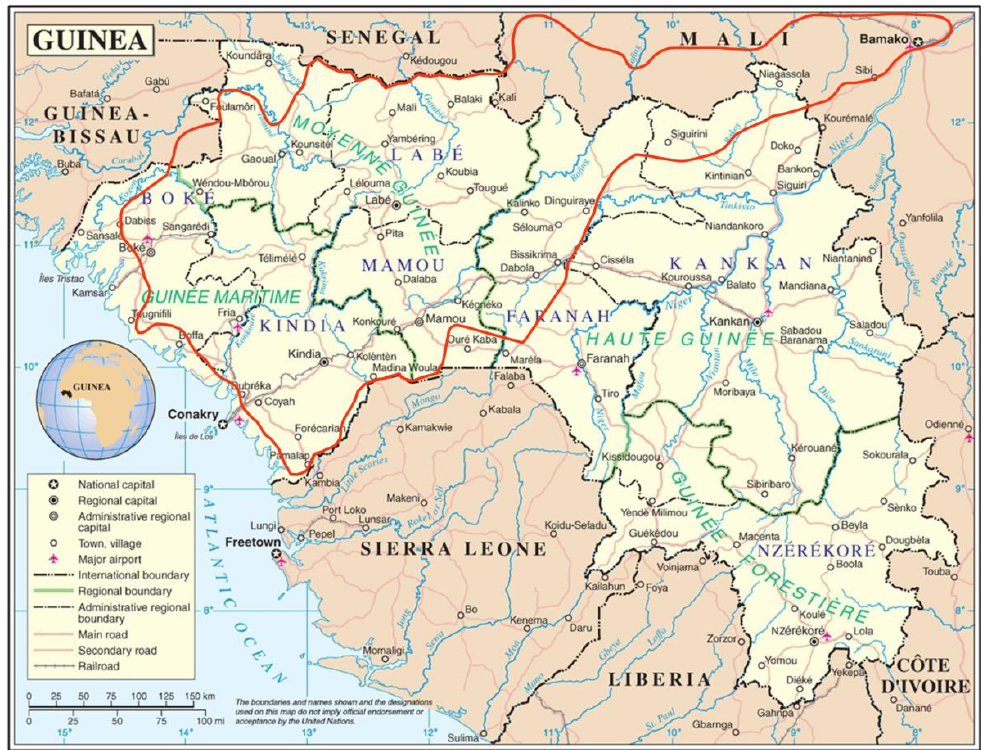
Figure 1. Overview map of the Republic of Guinea (the province of Fouta Djallon—Mandingo is red-outlined).